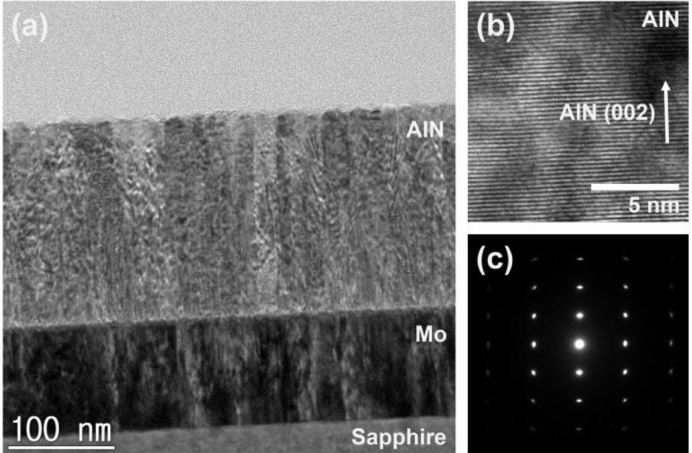
Figure 7. ( a ) Cross-sectional transmission electron microscopy (TEM) image of the AlN thin film on the Mo/sapphire substrate structure. ( b ) High-resolution TEM image and ( c ) selected area electron diffraction (SAED) pattern of the AlN thin film on the Mo/sapphire